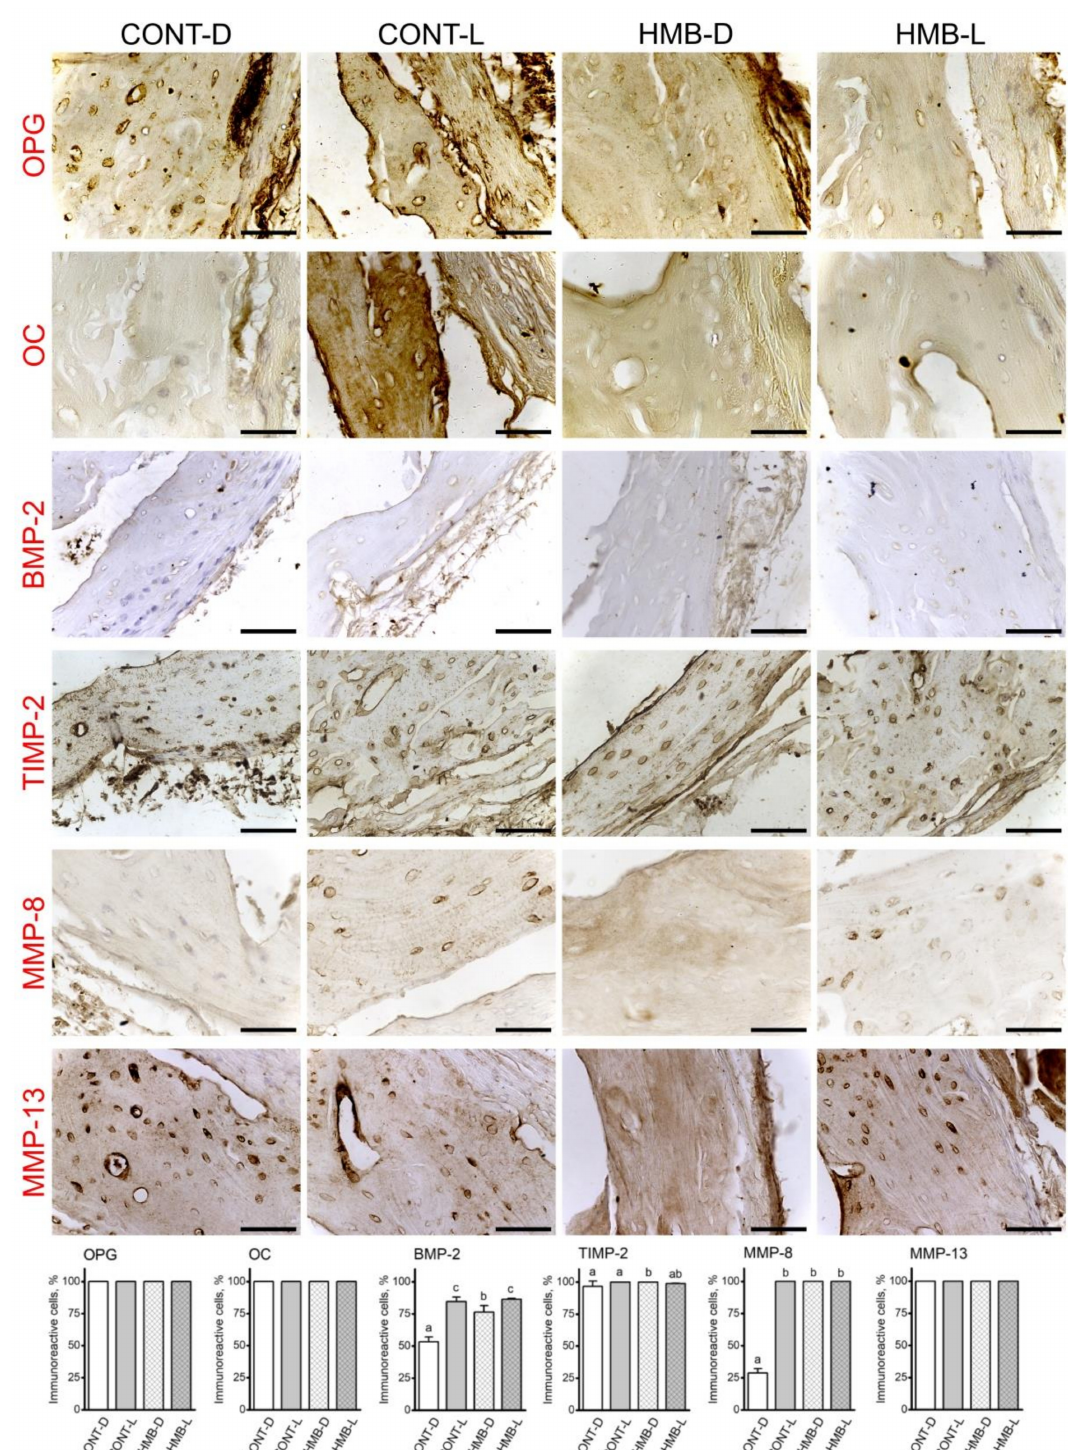
Figure 7. Representative images of the immunohistochemical reactions and the percent of immunoreactive cells for osteoprotegerin (OPG), osteocalcin (OC), bone morphogenetic protein 2 (BMP-2), tissue inhibitor of metalloproteinases 2 (TIMP-2), matrix metalloproteinase 8 (MMP-8) and matrix metalloproteinase 13 (MMP-13) in the compact bone of femora from pregnant female controls (not receiving HMB) at delivery (CONT-D) or after the lactation period (CONT-L) and from pregnant HMB females (receiving HMB at a dose of 0.02 g/kg b.w. during the middle trimester of pregnancy) at delivery (HMB-D) or after the lactation period (HMB-L). All the scale bars represent 40 µ m. Bar plots show the percentage of immunoreactive osteocytes in the trabecular bone in each